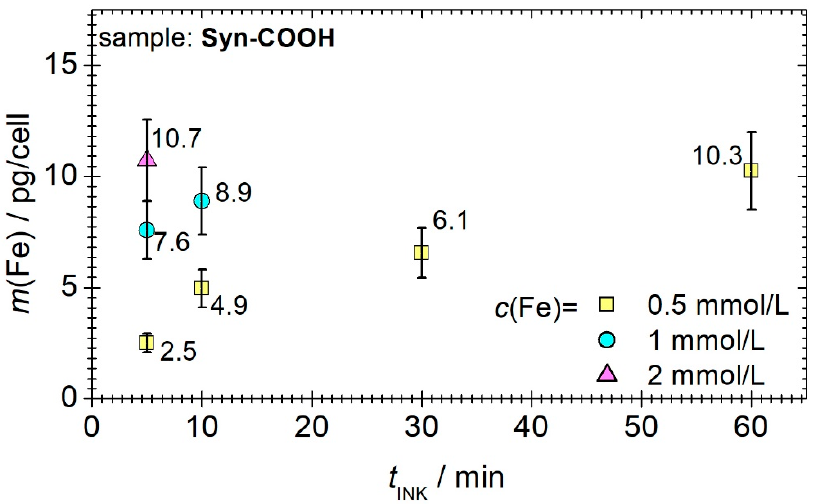
Figure 5. The iron mass determined by MPS at B = 12 mT as a function of the incubation time for three different iron concentrations of Syn-COOH ( c (Fe) = 0.5, 1, and 2 mmol/L) in 10 6 THP-1 monocytes. The uncertainty was determined from an 8-fold repeat of the measurement. For iron concentrations higher than 0.5 mmol/L, only t INK for 5 and 10 min was reproducibly determined due to higher cell stress and cell death.